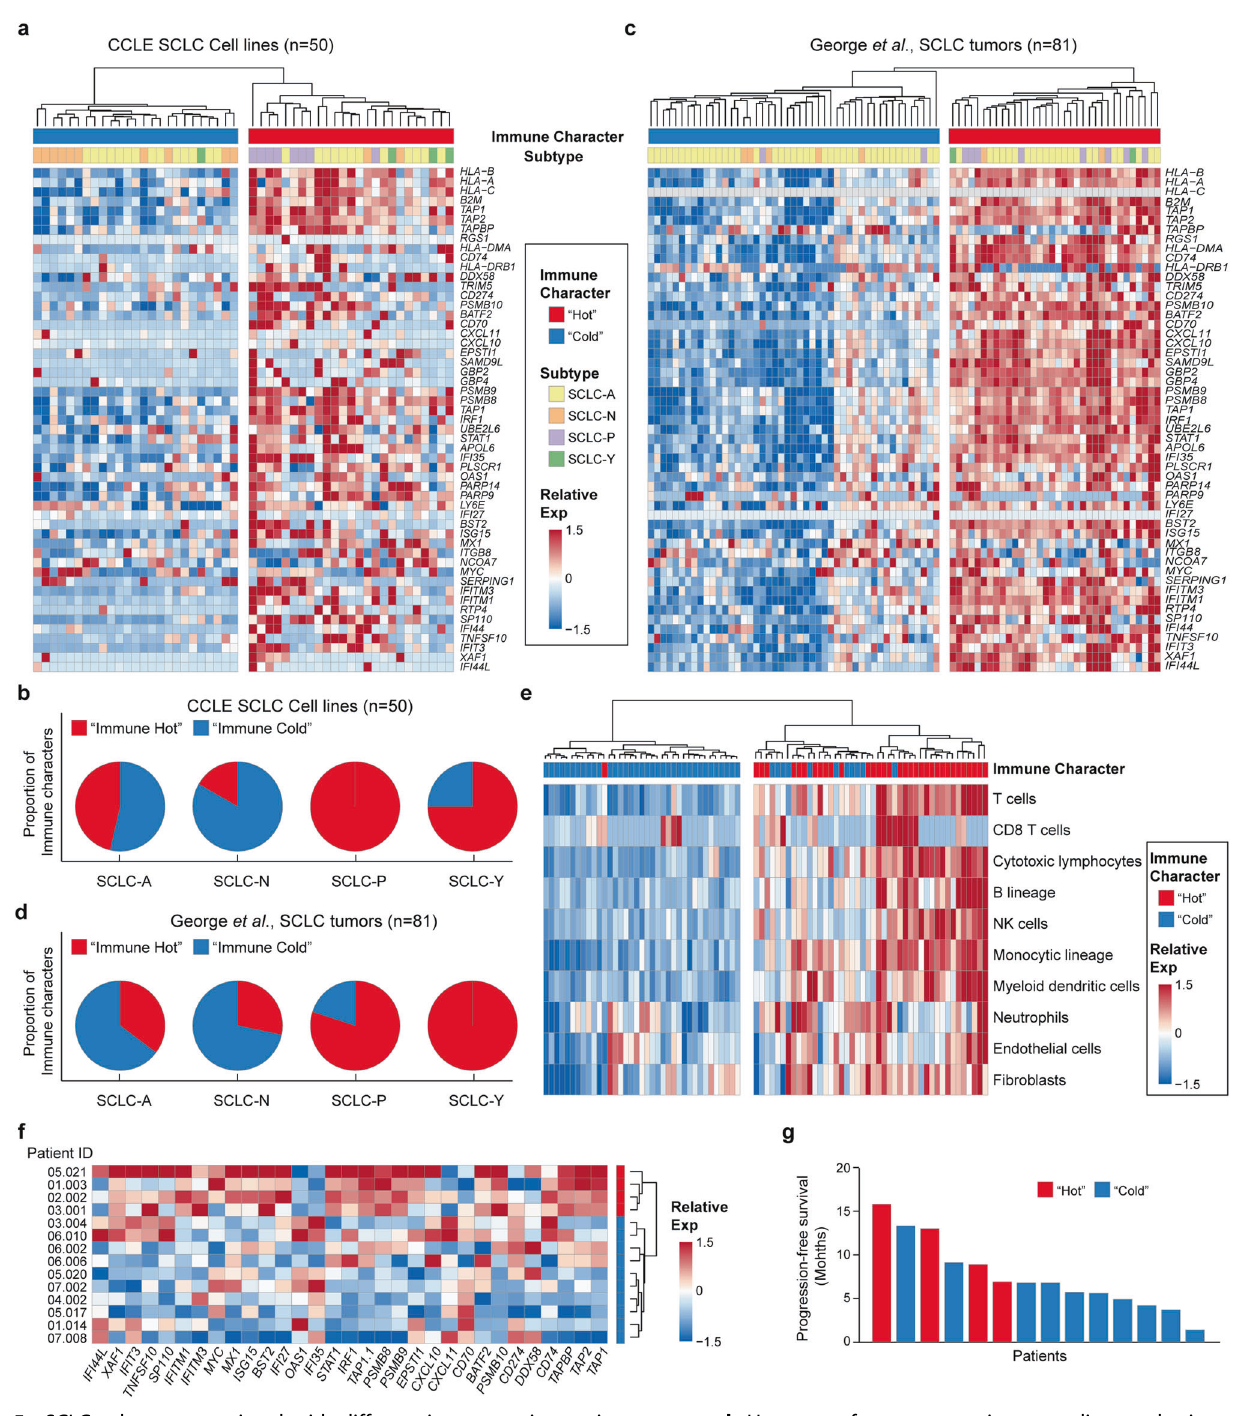
Fig. 7 SCLC subtypes associated with different immune microenvironments. a , b Heatmap of gene expression according to the immune signatures shown in Fig. 3e in 50 SCLC cell lines from the CCLE ( a ) and 81 SCLC tumor samples described by George et al. ( b ). The immune characteristics of “ hot ” and “ cold ” tumors, as well as SCLC subtypes, are indicated. c , d Pie charts illustrate the proportion of different immune characteristics in SCLC subtypes from 50 SCLC cell lines from the CCLE ( c ) and 81 SCLC tumor samples described by George et al. ( d ). e Qualitative and quantitative analyses of the abundance of eight immune and two stromal cell populations in 81 SCLC tumor samples described by George et al. f Heatmap of gene expression according to the immune signatures shown in Fig. 3e in 14 SCLC patients who received ICB treatment. g Progression-free survival (PFS) of these 14 SCLC patients. The immune “ hot ” (red) and “ cold ” (blue) characteristics are indicated